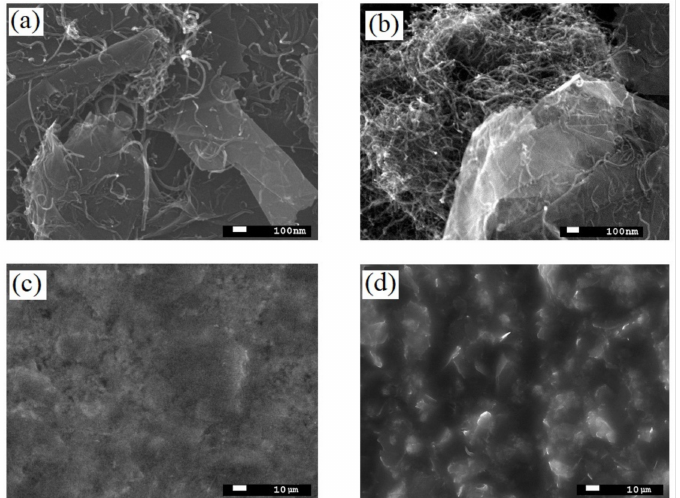
Figure 2. SEM images of ( a ) G/CNT (8:2, w/w ) hybrid fillers; ( b ) example of agglomerated hybrid fillers (G/CNT (2:8, w/w )); ( c ) surface of 15 wt.% silicone composite with G/CNT (8:2, w/w ) filler; ( d ) example of composite surfaces with agglomerated hybrid fillers (G/CNT (2:8, w/w